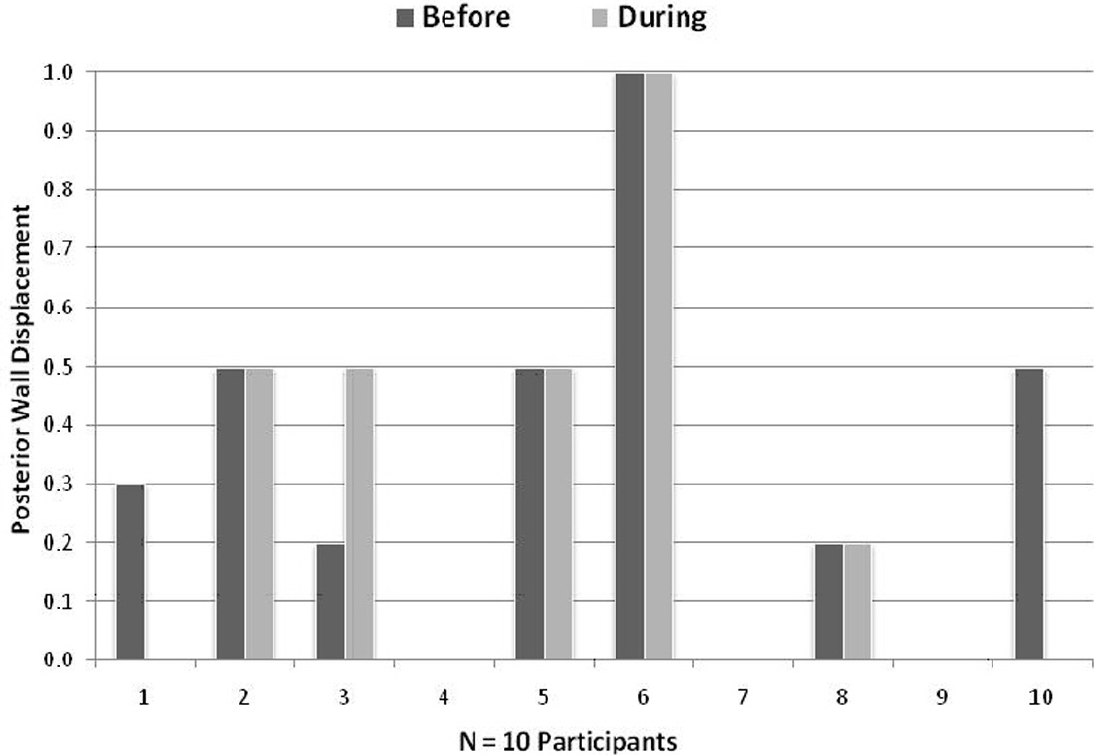
- Participants 4, 7 and 9 did not present posterior pharyngeal wall dysplacement before or during diagnostic terapy - Due to velar displacement, which made contact with adenoid, it was not possible to observe posterior wall displament during diagnostic therapy for subjects 1 and FIGURE 4- Maximum posterior pharyngeal wall displacement before and after diagnostic therapy for all 10 participants